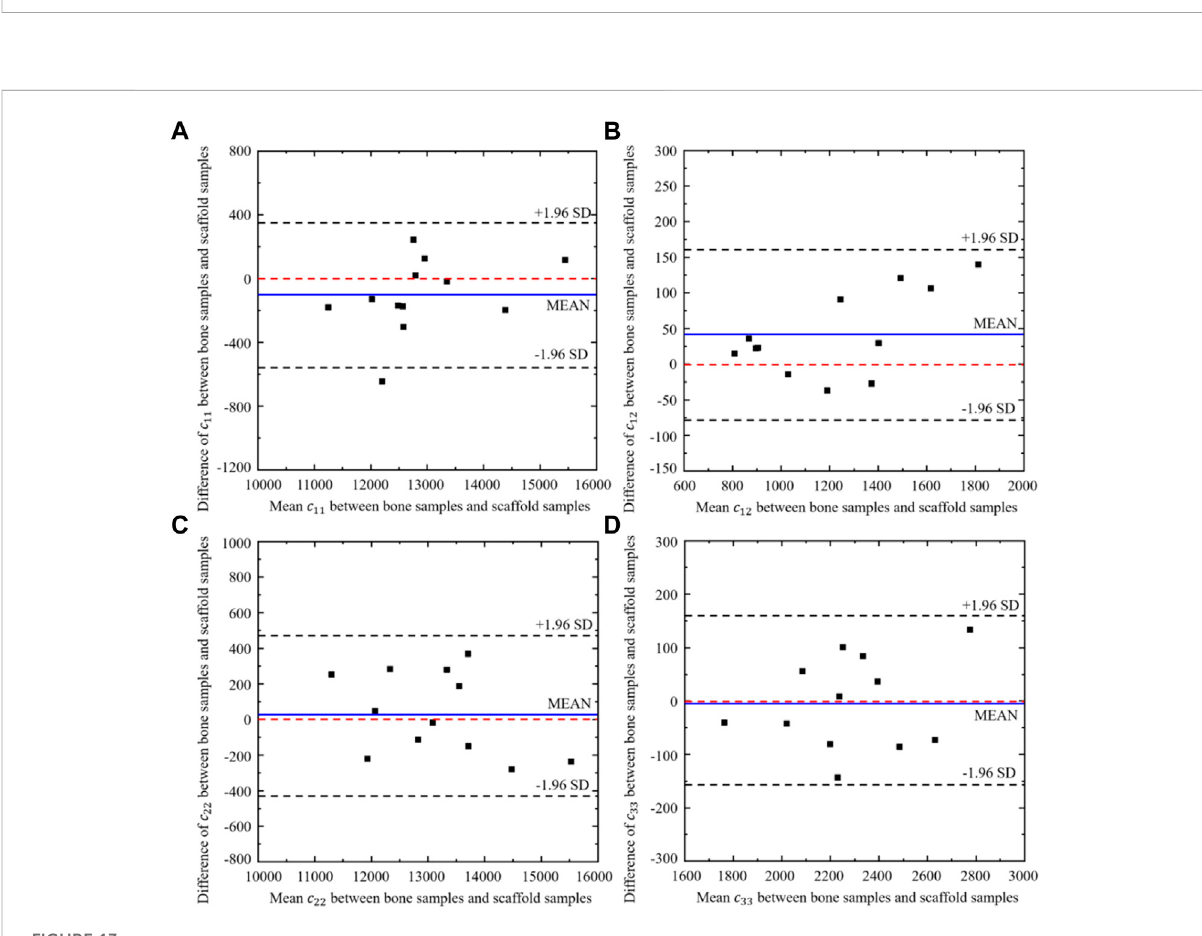
Frontiers in Bioengineering and